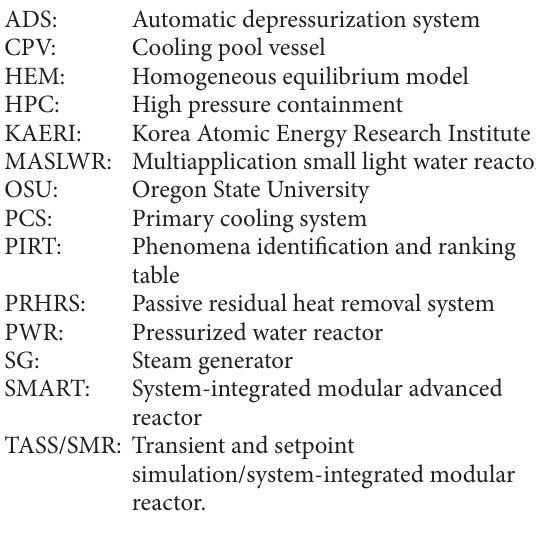
Ranking Table of Thermal Hydraulic Phenomena for SMART